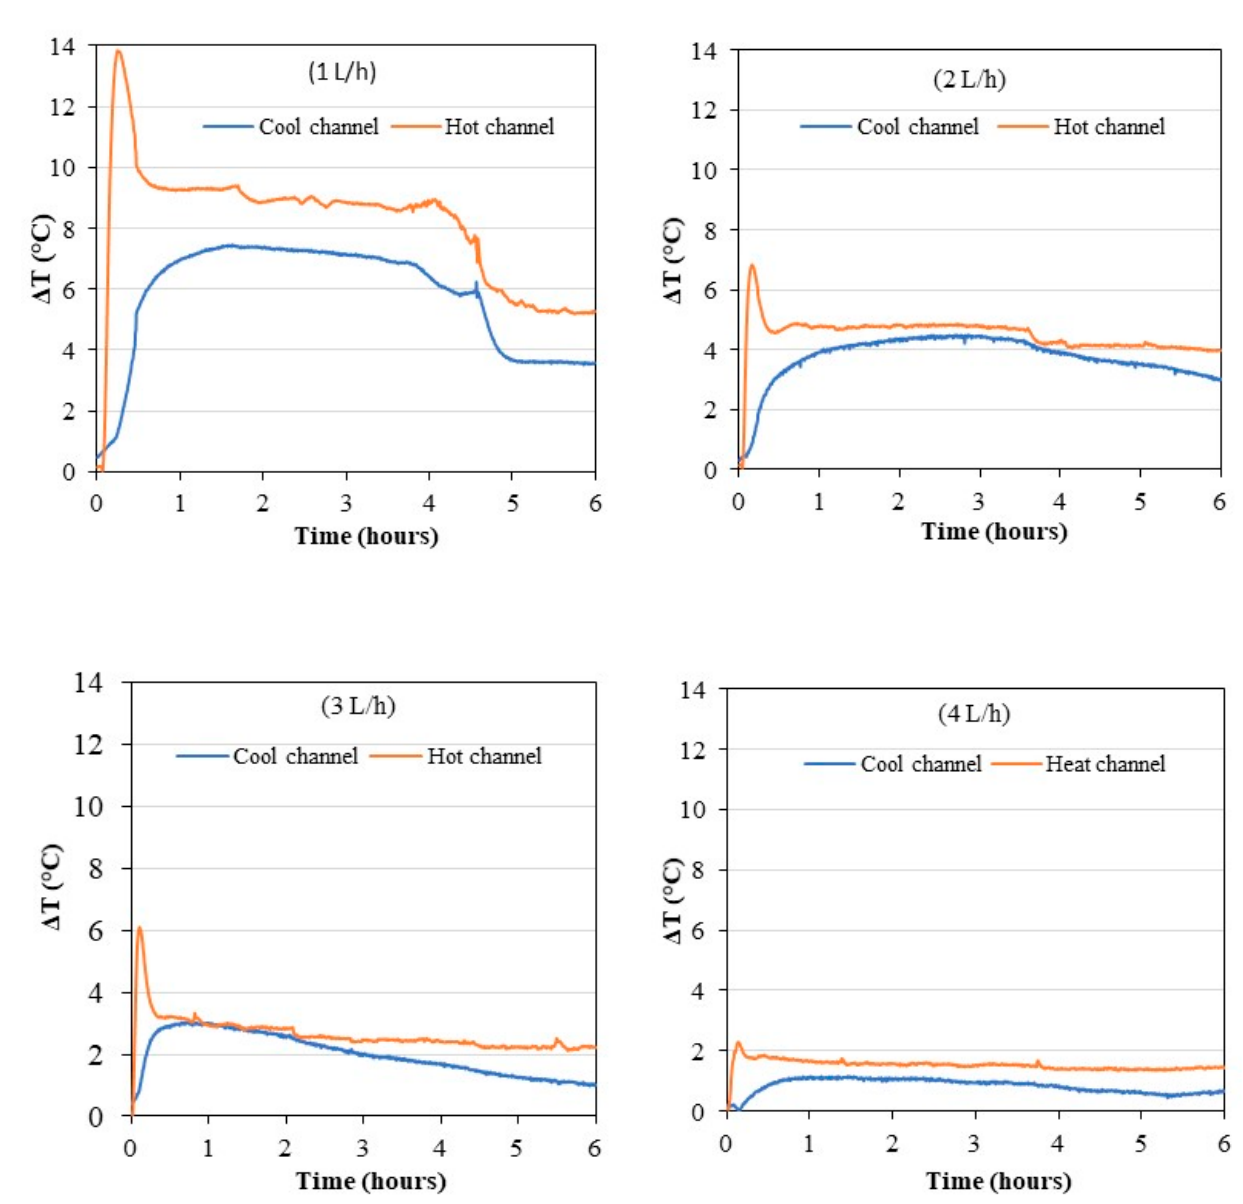
Figure 11. Evolution of the temperature differences of the channels at the different operating flow rates in continuous